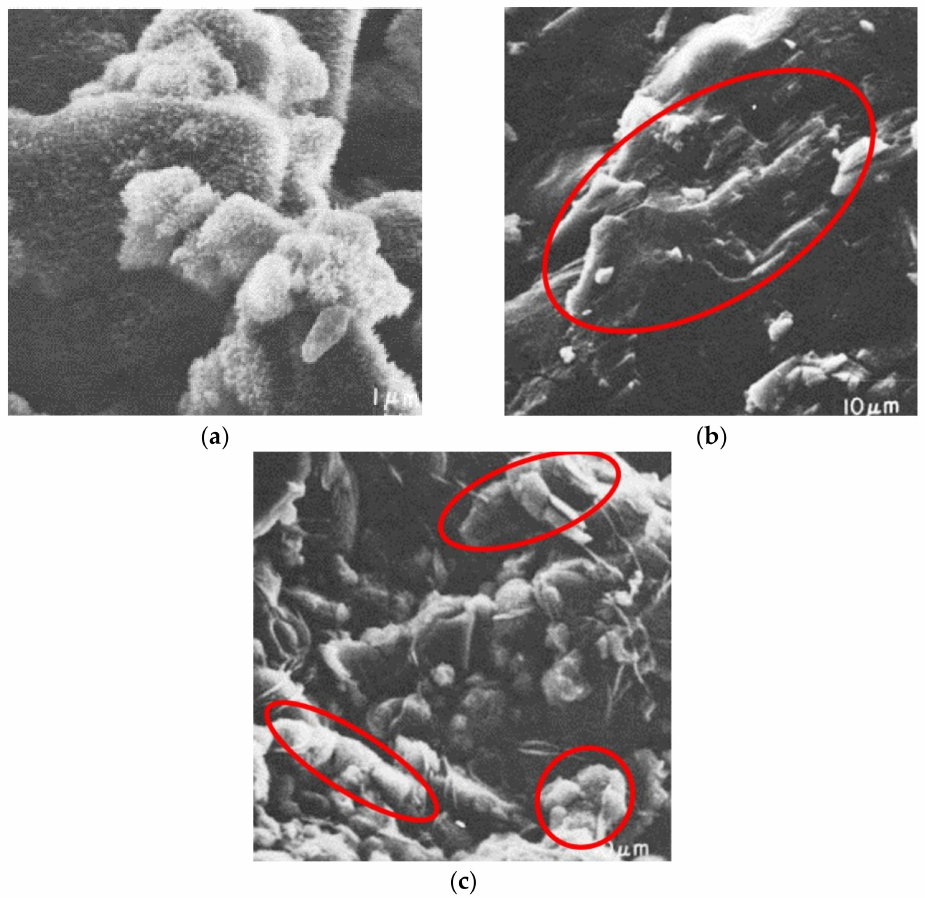
Figure 9. SEM images of the hydration products of alite in the presence of ( a ) 0% CaCl 2 giving small needles, ( b ) 2% CaCl 2 giving thick plates and ( c ) 5% CaCl 2 giving a spongey consistency